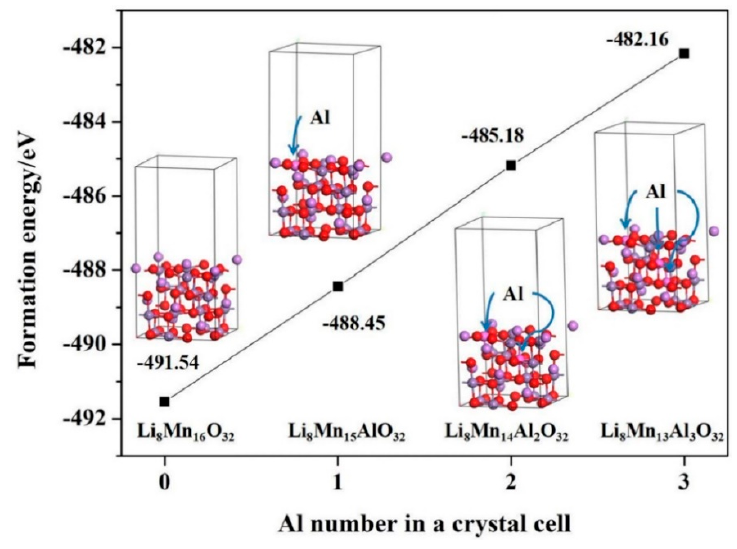
Figure 3. Calculated formation energy of Al-doped cubic spinel LiMn 2 O 4 (LMO). Reprinted from ref. [137] with permission of Elsevier.